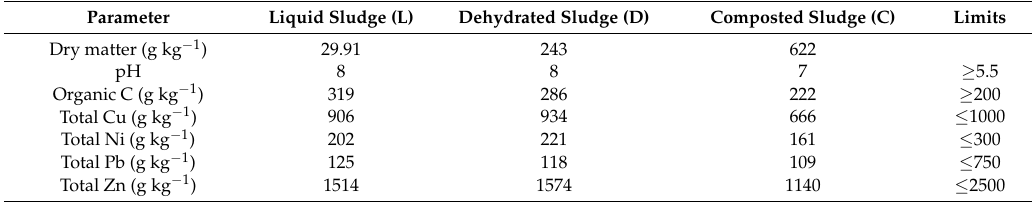
Table 5. Characteristics of the sewage sludge (average values) and limits (D.L. 27 January 1992 n. 99). Values refer to dry weight.